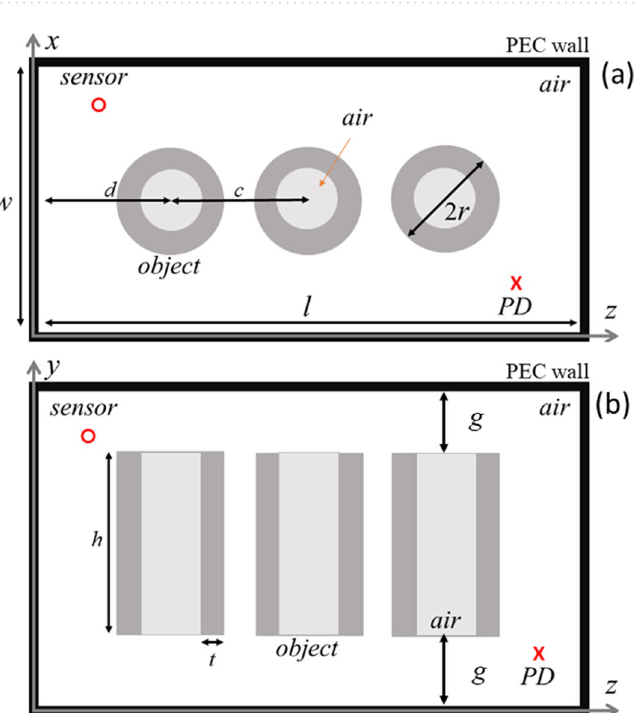
Figure 4. Geometry of the 3D power transformer model, including a metallic tank (thick black PEC frame), a PD source (red cross), a sensor (red circle), and three windings. The tank is symmetric along xoy and xoz planes.